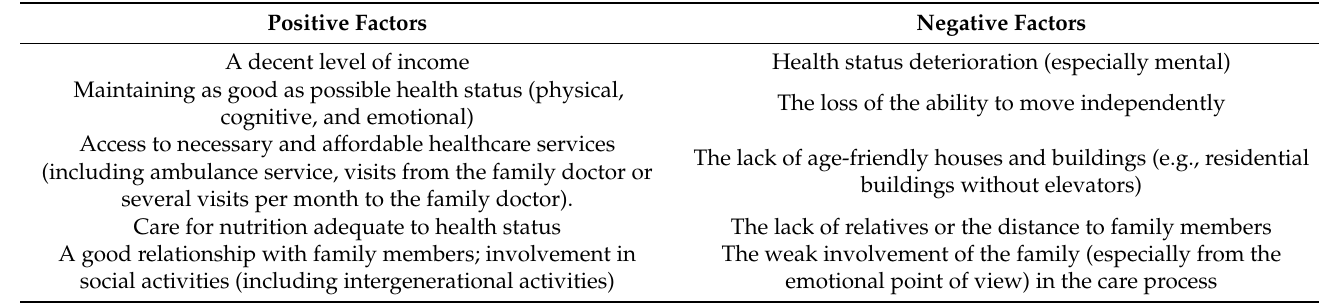
Table 3. Factors influencing the quality of life of older dependent